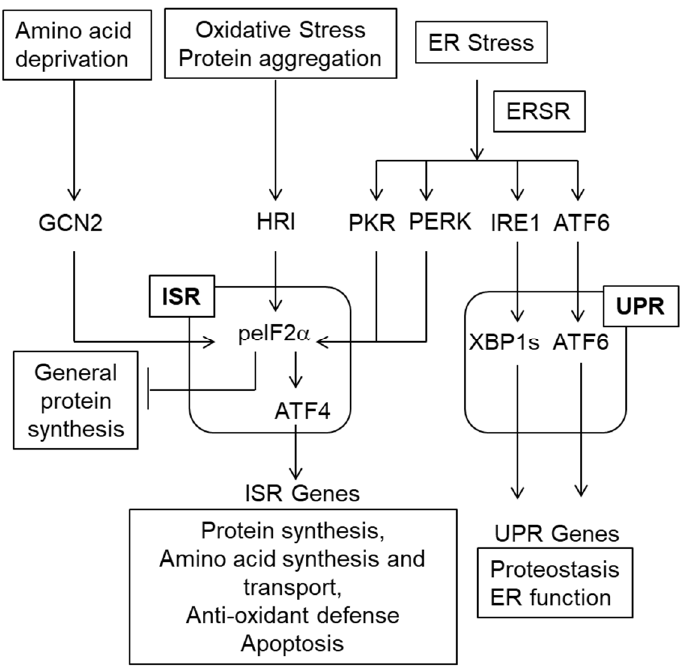
Figure 3. The ISR/ERSR/UPR pathway. Various stressors including ER stress activate the ISR [20]. The ERSR also includes the UPR [19]. Note that the ISR inhibits general protein synthesis and increases translation of select mRNA such as Atf4 . Then, ATF4 mediates the transcriptional arm of the ISR. While regulation of gene transcription via sXBP1 and ATF6 is the major component of the UPR, IRE1 may also activate the pro-apoptotic kinase JNK as well as degrade ER-associated mRNAs as well as miRNAs (not shown on this schematic) [130]. Unlike the pro-homeostatic transcriptional UPR, those IRE1 activities are cytotoxic [130].